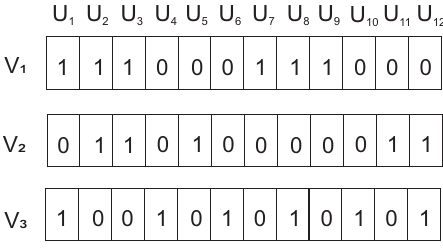
Figure 2. Vector representation for connected dominating set (CDS) shown in Figure